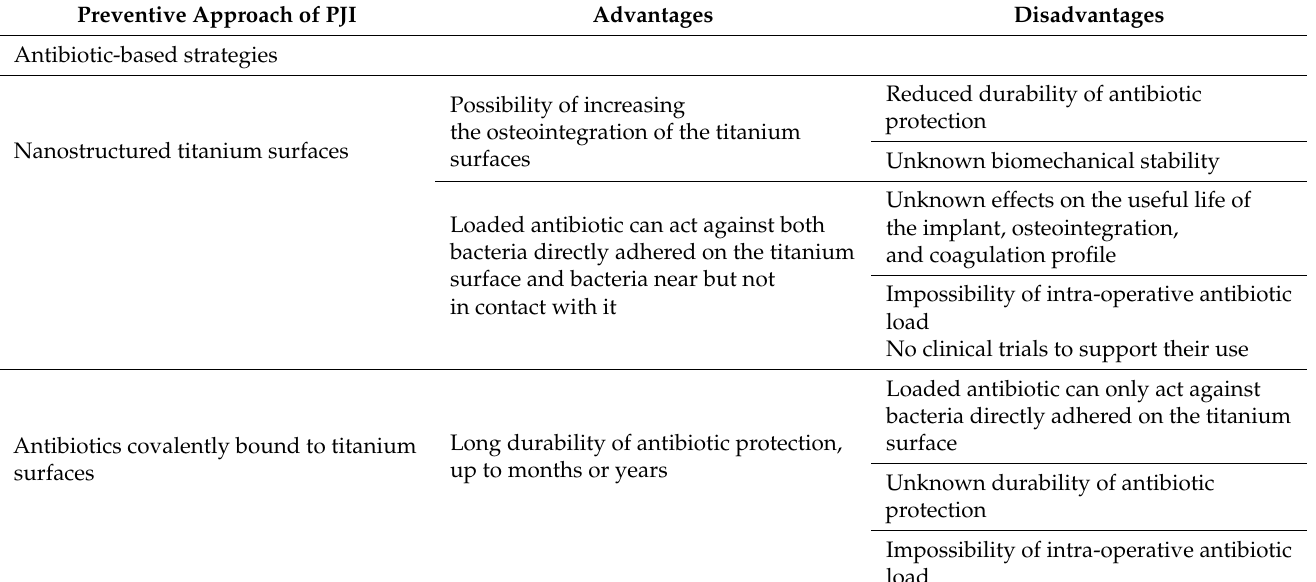
Table 5. Some of the most important advantages and disadvantages related to each preventive approach of